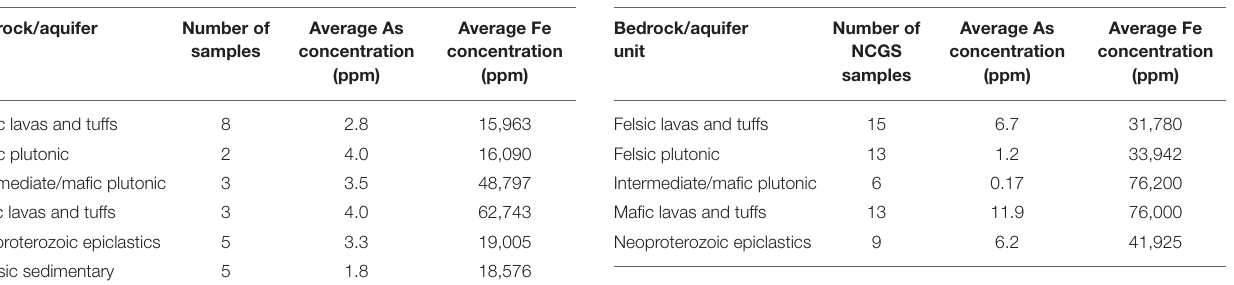
TABLE 1 | The average arsenic and iron concentrations in the bedrock unit samples from this study. Bedrock/aquifer unit